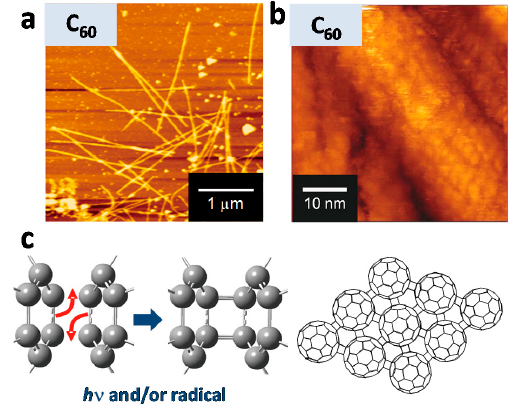
Figure 9. ( a ) AFM image of long and straight C 60 nanowires. ( b ) STM image of C 60 nanowires. ( c ) Proposed dimerization reaction via 2 + 2 cycloaddition. The right schematic shows the expected structure of the polymerized fullerenes. Reproduced with permission from ref. [109] ©2012, Nature Publishing Group.